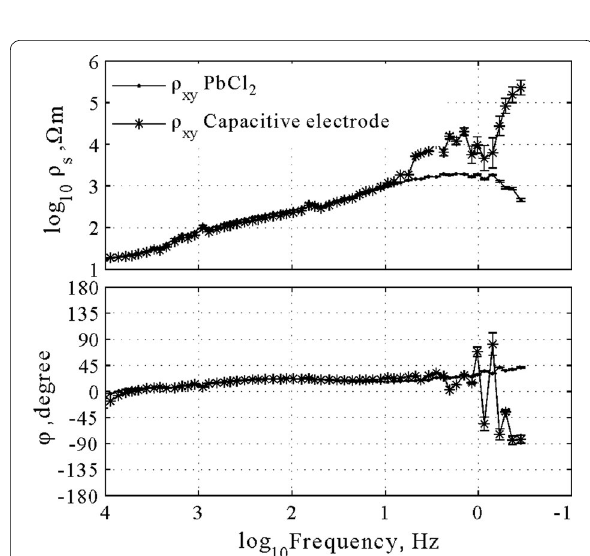
Fig. 12 MT response sounding curves of the two types of